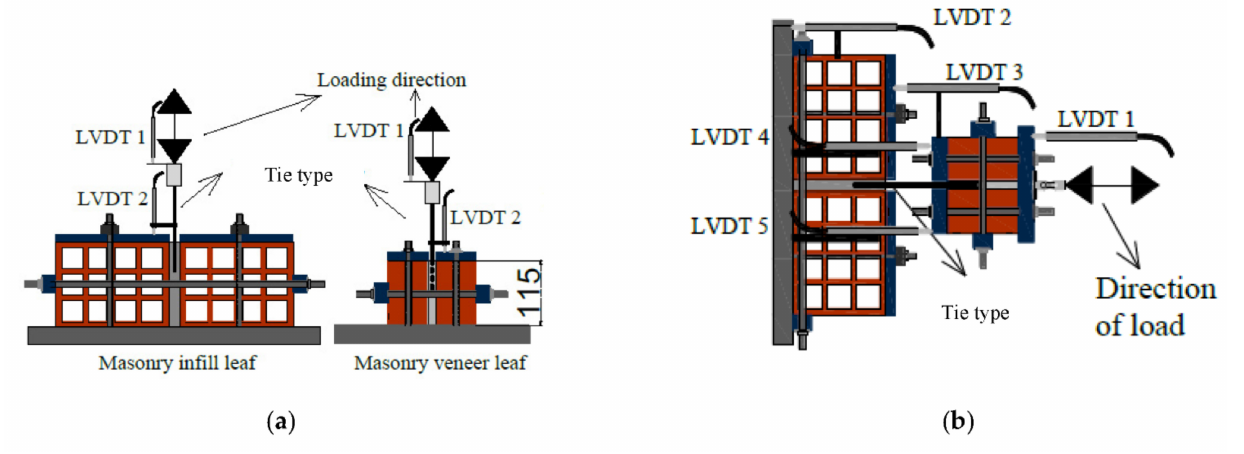
Figure 5. Representative scheme of the test setup for the different specimens: ( a ) single assemblages; ( b ) complete assemblage [34]. Units in